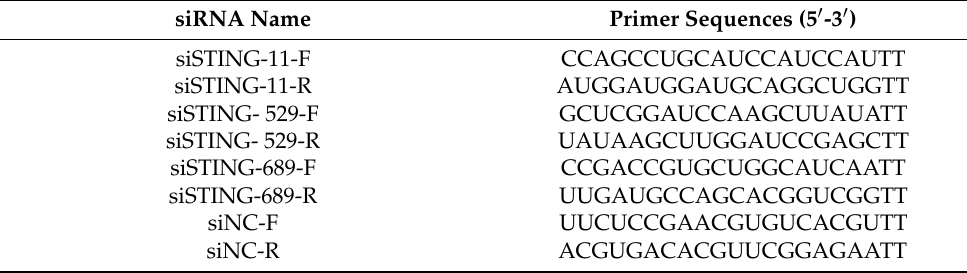
Table 3. The siRNA sequences for porcine STING genes.